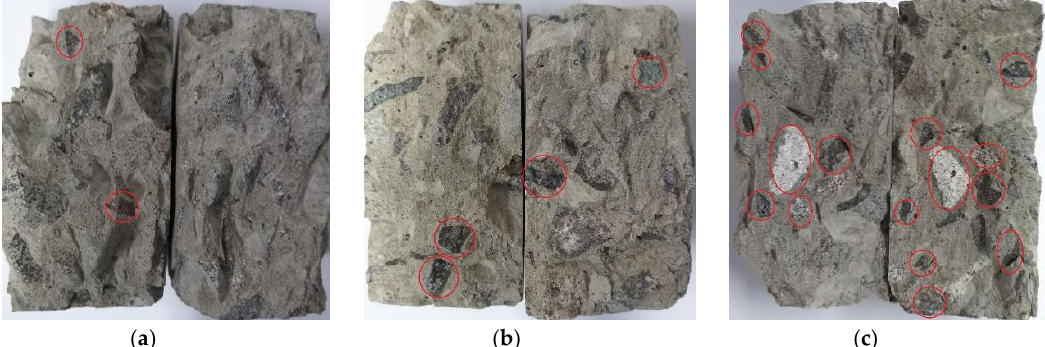
Figure 6. Typical fracture surfaces of concrete specimens under different strain rates: ( a ) Strain rate: . ε = 45 s − 1 ; ( b ) Strain rate: 70 s − 1 ; ( c ) Strain rate: 105 s − 1 . Table 6. Dynamic properties of three series of concrete specimens under di ff erent impact velocities. Impact Velocity (m / s) Concrete